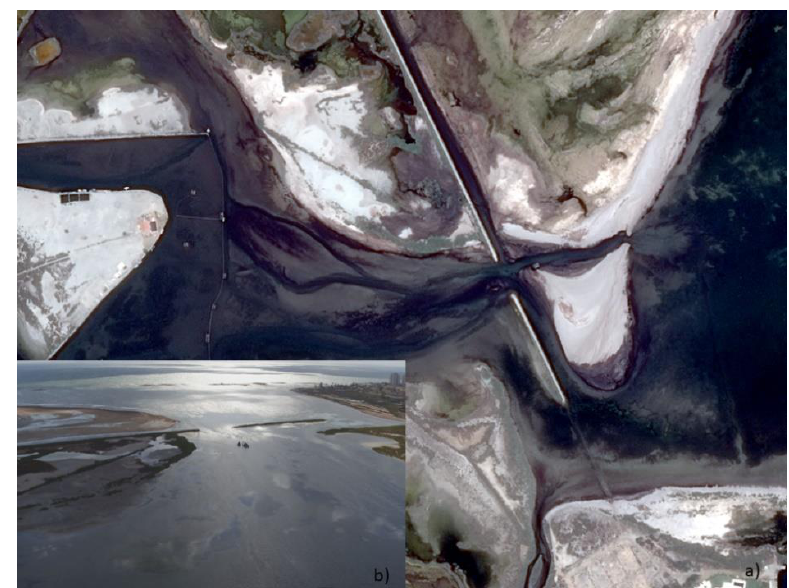
Figure A3. Start of depth restoration in the Encañizada: ( a ) Pleiades image 28 June 2017; and ( b ) aerial image 15 August 2017, after the completion of maintenance work.